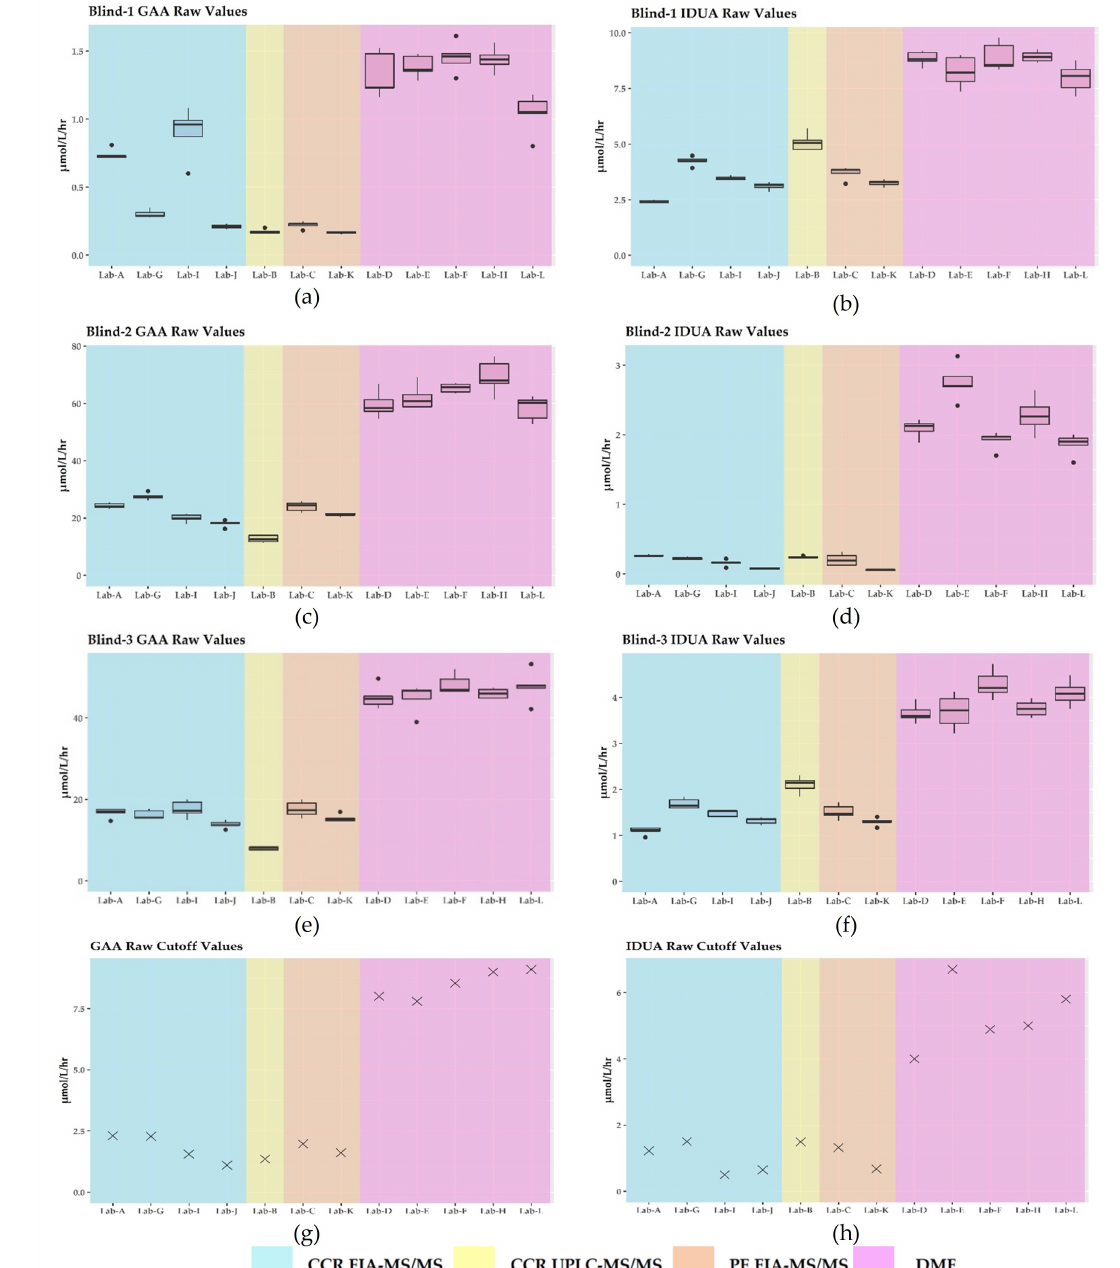
Figure 1. Plots for the raw enzyme activities by laboratory: ( a ) deficient GAA specimen; ( b ) normal IDUA specimen; ( c ) normal GAA specimen; ( d ) deficient IDUA specimen; ( e ) normal GAA specimen; ( f ) low IDUA specimen; ( g ) GAA cutoff; ( h ) IDUA